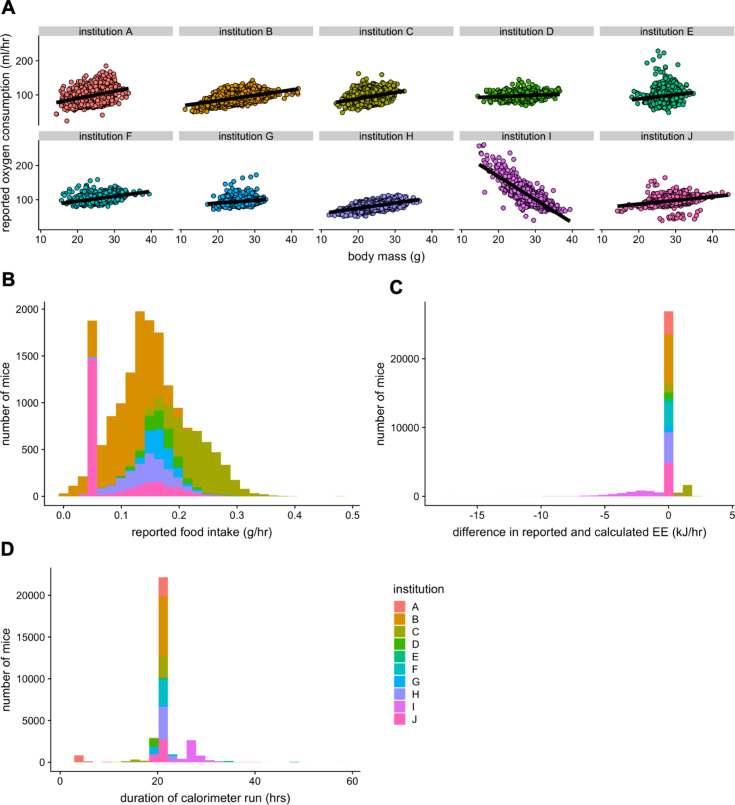
Irregularities in the IMPC dataset.A plot of VO2 vs total body mass for each of the 10 sites in the IMPC (A). Only one site demonstrates a negative mass effect due to a faulty calculation. Distribution of food intake among the reporting sites. The 0.05 g food intake was erroneously overrepresented (n = 10,021 males and 6818 females) (B). Two sites reported EEs calculated by a different equation from the rest of the dataset (C). Durations of calorimetry run data included in IMPC database (D). These four issues were corrected prior to analysis. n = 25,089 males and 10,725 females unless otherwise specified.